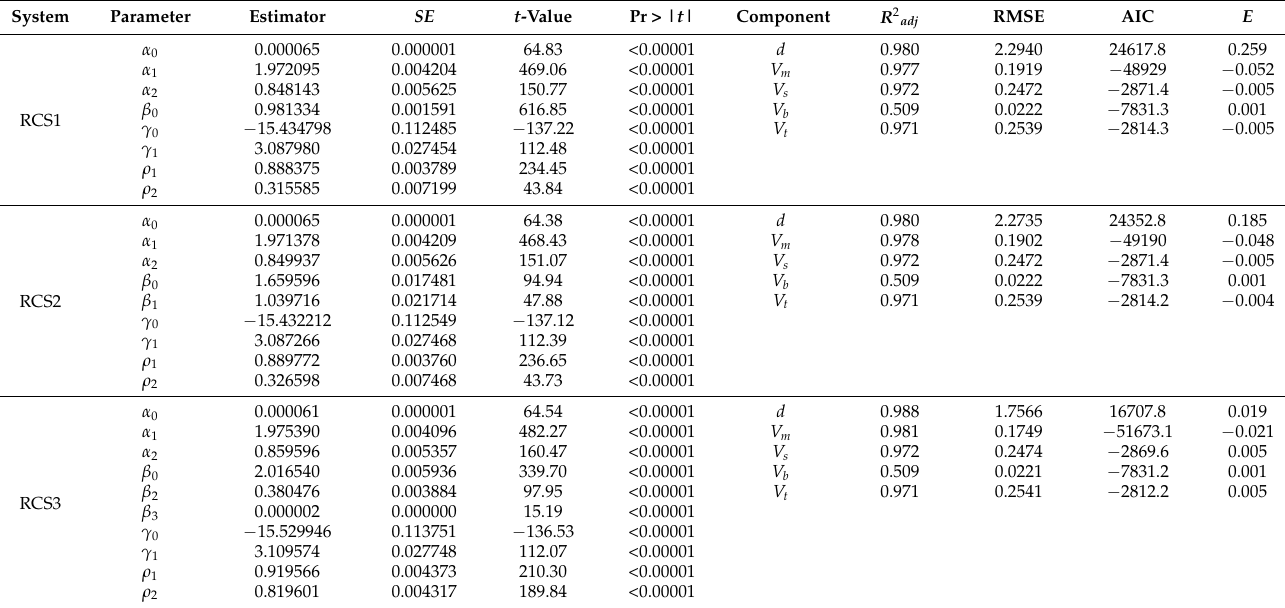
Table 3. Parameter estimates and fit statistics for the reduced compatible systems